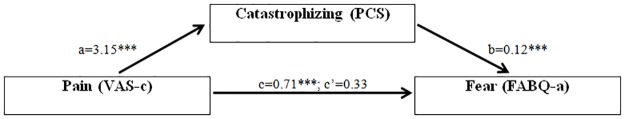
Mediation of the relationship between pain and fear through catastrophizing.Coefficients for the different pathways (a, b, c) are displayed. The indirect effect (a x b pathway) for PCS was 0.37 (95% CI 0.15 to 0.62). *** is p<0.001.